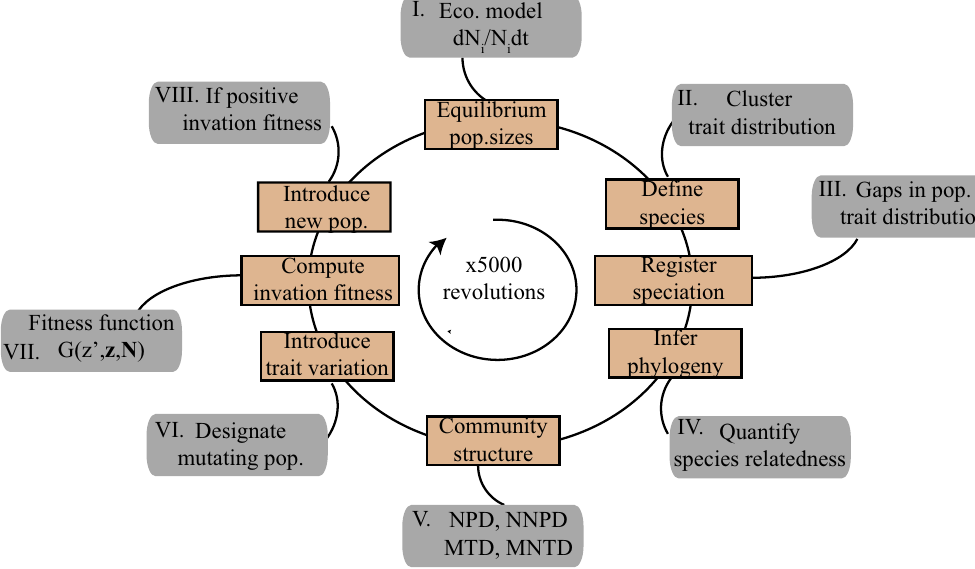
Figure 1. Major components of the eco-evolutionary model implementation and analyses. Each evolutionary time step in the model includes eight components that were conducted in sequence 5000 times (denoted as revolutions in the circular illustration). Light brown boxes denote the purpose of each analysis component and gray boxes illustrate the means or tools for doing so. A trait-based ecological model is used to compute equilibrium population sizes in a given community ( I ). Species are defined according to their traits ( II ), speciation events are registered ( III ) and phylogenic relationships are quantified ( IV ). Community structure (NPD, NNPD, MTD, and MNTD) is quantified ( V ). Trait variation is introduced through mutations ( VI ), invasion fitness of mutants is computed ( VII ) and mutants that have positive invasion fitness are introduced to the community ( VIII ). The next revolution/ evolutionary time step is then started as ecological community equilibrium is re-computed ( I ). Figure produced in Adobe Illustrator CS6 Version